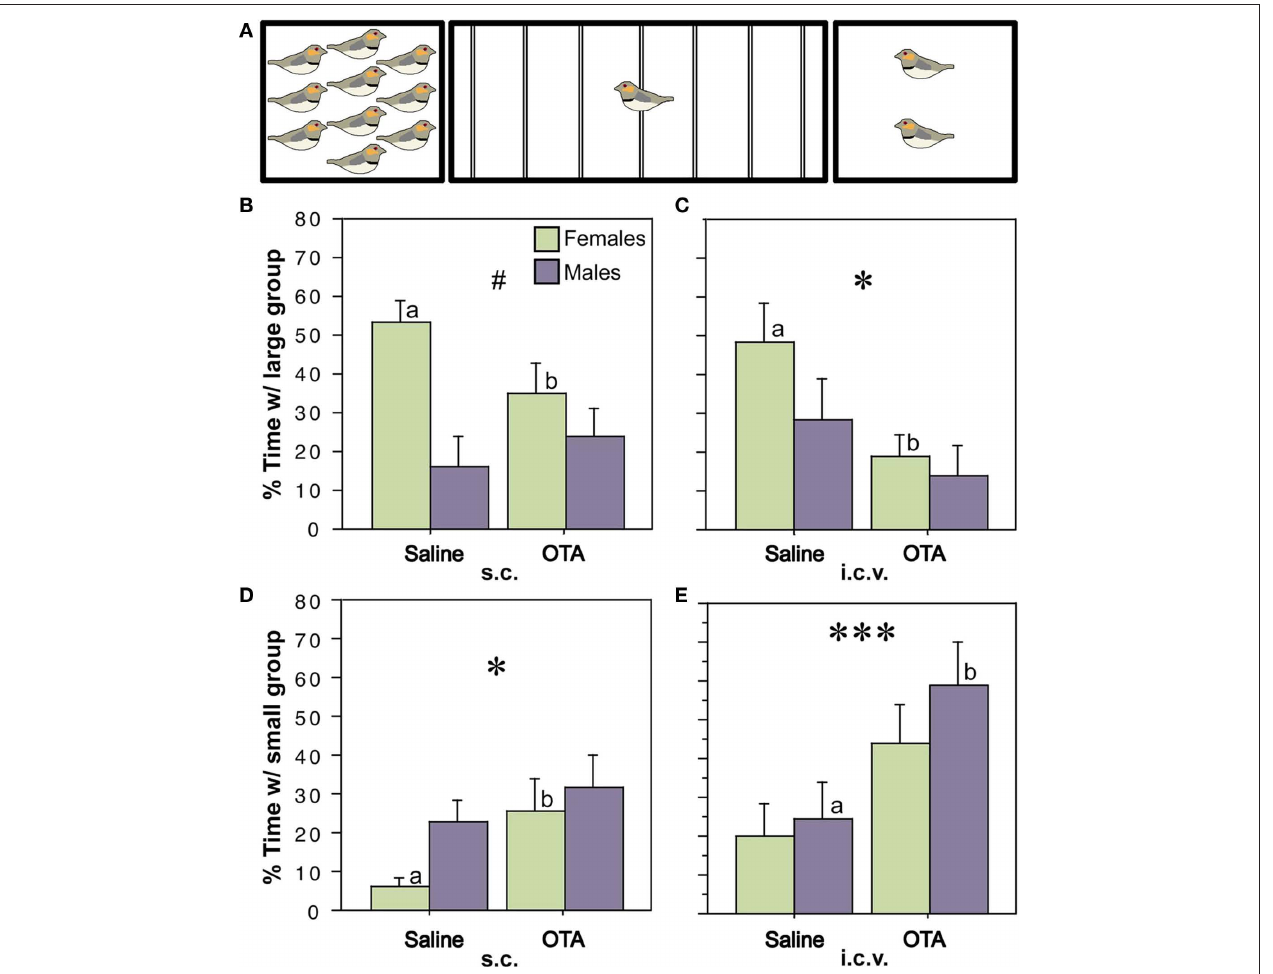
intracerebroventricular (i.c.v.) administrations of the oxytocin antagonist desGly–NH , d(CH ) [Tyr(Me) 2 , Thr 4 ]OVT (OTA; 250 ng), reduce the amount of 2 2 5 time that zebra finches spend in close proximity to the large group (B,C) and increase time in close proximity to the small group (D,e) . * P < 0.05, *** P < 0.001, main effect of Treatment; # P < 0.5 Sex*Treatment; n = 12 m, 12 f. Letters above the error bars denote significant within-sex effects. Modified from Goodson et al.